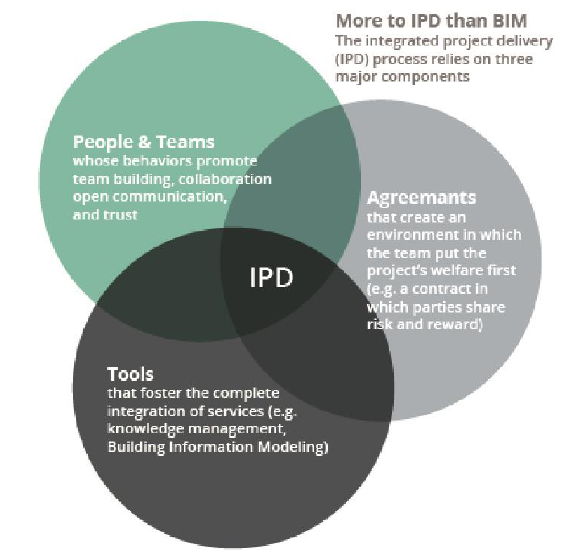
Figure 5. IPD Scheme. The integrated project delivery process relies on three major components: people & teams, agreements,